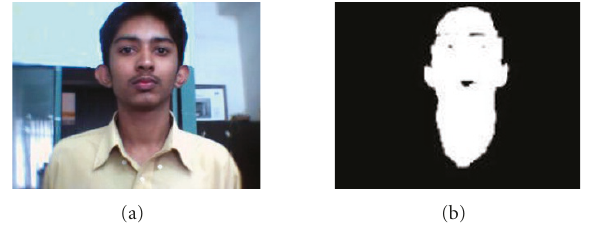
Figure 4: Subject with big ears and the corresponding skin cluster.